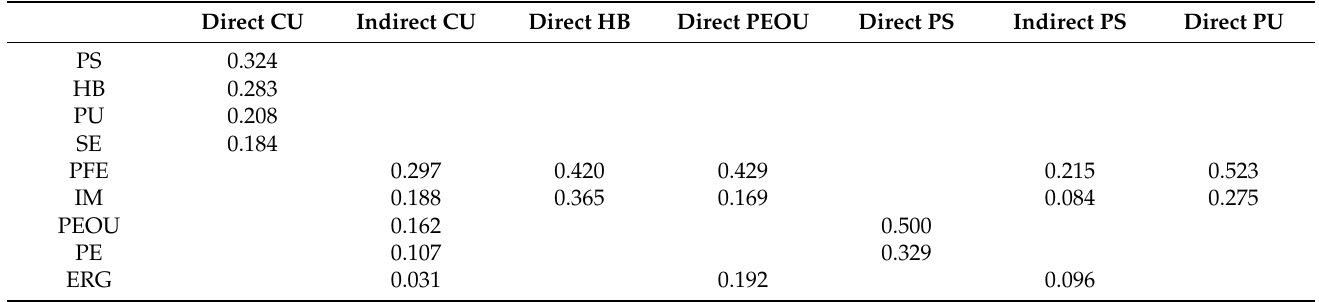
Table 4. Path coefficient